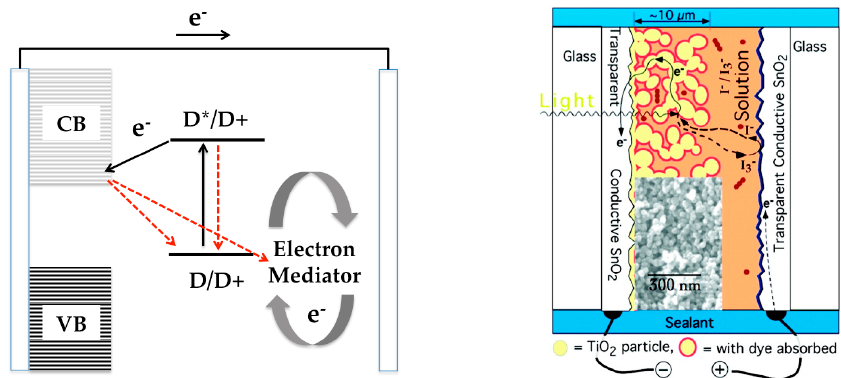
Figure 1. ( left ) Illustrative diagram of the functioning mechanism of a typical n-type DSC. The different competing forward (solid black lines) and back (dotted red lines) electron transfer reactions are also indicated; ( right ) Physical composition of a DSC and SEM image of the dye-sensitized TiO 2 film (adapted from [15]).